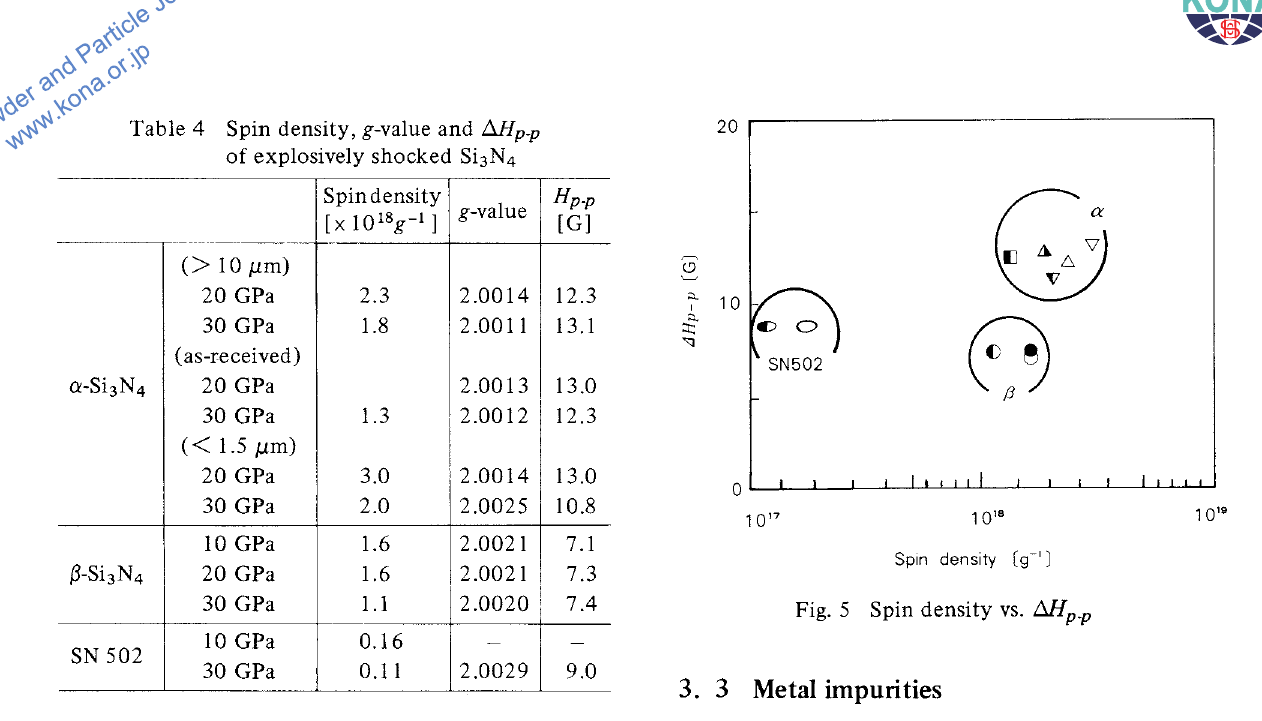
Fig. 5 Spin density vs.